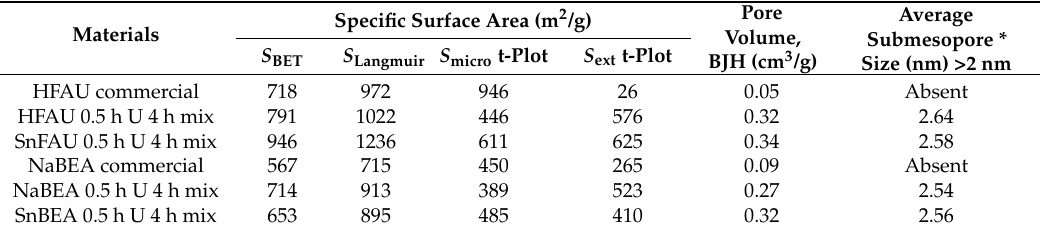
Figure 3. Isotherms of N 2 adsorption/desorption for materials based on zeolite BEA (from IB to IIIB ), distribution of pore size (from 1B to 3B ) and scanning electron microscope (SEM), SEM/EDX and transmission electron microscopy (TEM) images. Table 2. Porous structure parameters of synthesized hierarchical